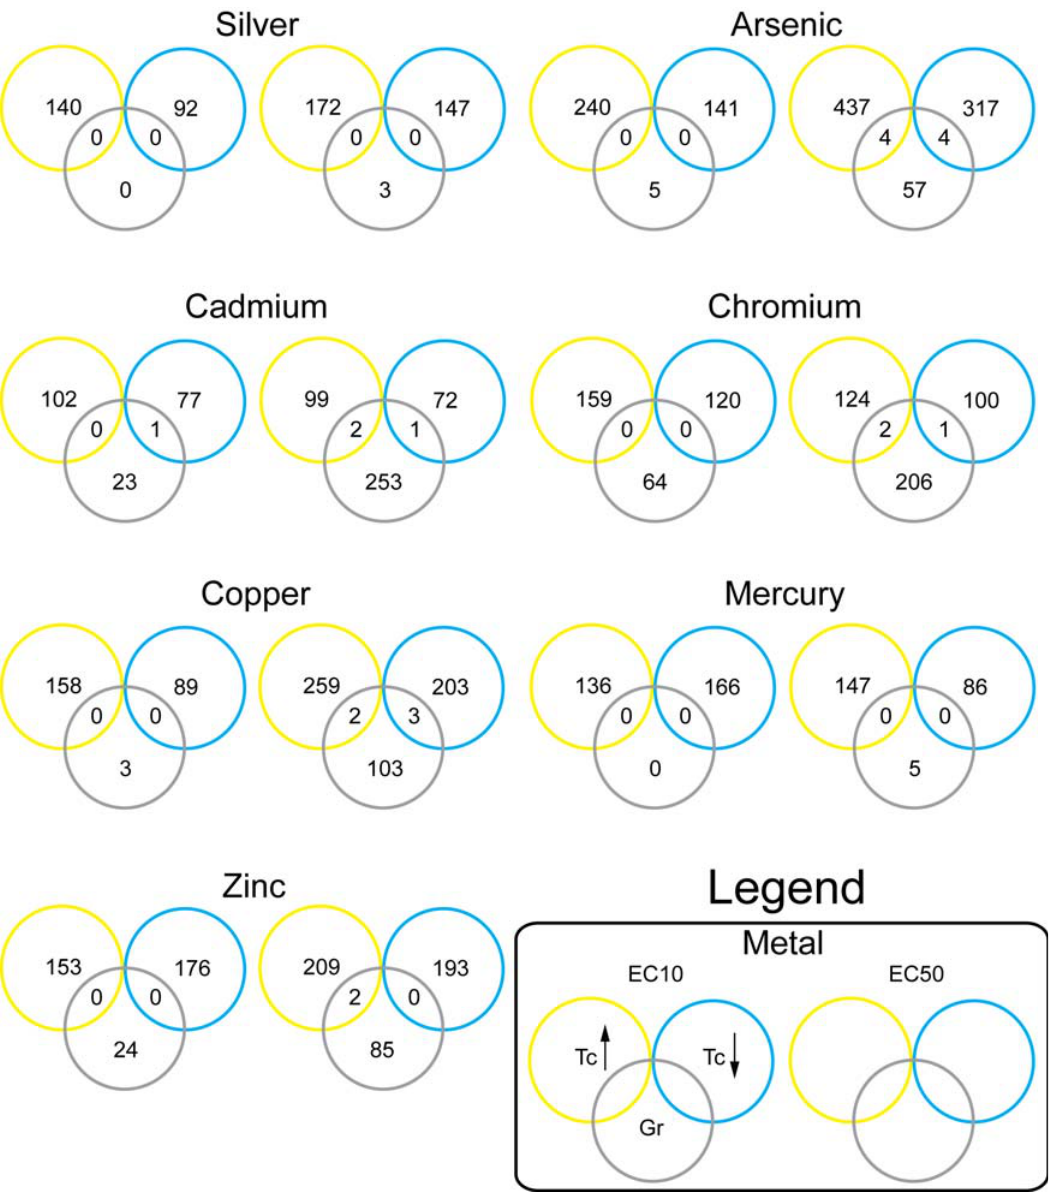
Figure 4. Identification of common genes between the metal-responsive transcriptome and deletome. Venn diagrams illustrate the distribution of genes whose level of expression increased ( Tc q ), decreased ( Tc Q ) and/or that were essential for resistance to metal toxicity ( Gr ). Genes located in the intersections of the datasets and their ontologies are presented in Table S5.